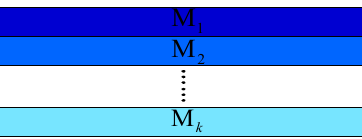
Figure 4. Diagram of the image blocks. Different blocks are represented by different colors.